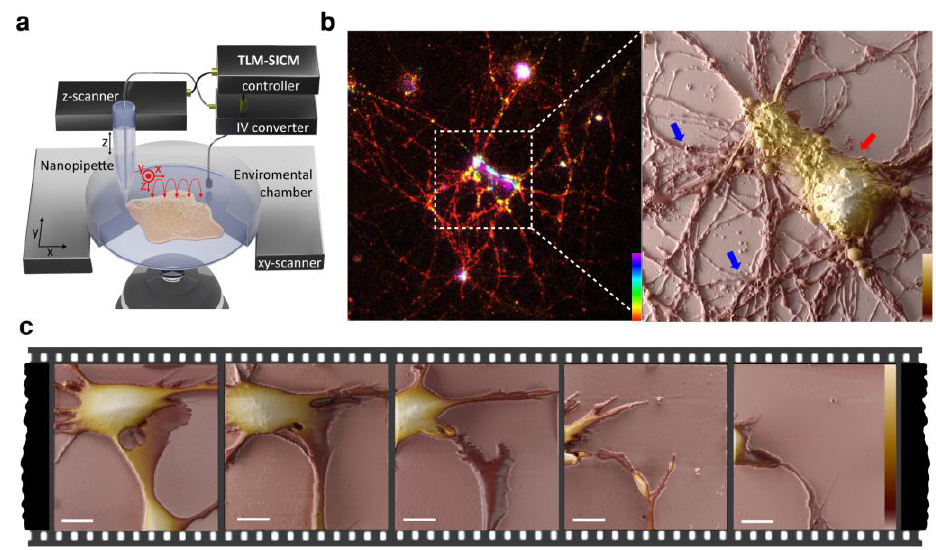
Figure 3. Scanning ion conductance microscopy (SICM) method for non-invasive live cell imaging at the nanoscale: ( a ) Schematic of SICM principle. Reprinted with permission under the terms of the Creative Commons CC-BY license from [128]; ( b ) Structured illumination microscopy (SIM) z-stack image of a mouse cortical neuron, fixed in 4% PFA and stained for tubulin, and SICM image on a 60 µ m area. The red arrow shows the cell body and the blue arrows show the intricate network of neurites, Z scale bar: 0–8 µ m. ( c ) Time-lapse live imaging of neuroblastoma cell migration using SICM, Z scale bar: 0–7.5 µ m, lateral scale bar: 10 µ m, temporal resolution: 20 min per image.